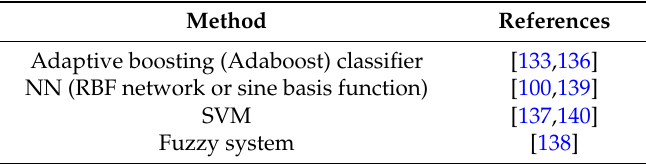
Table 16. Methods for classification in the fitness classification process flow.